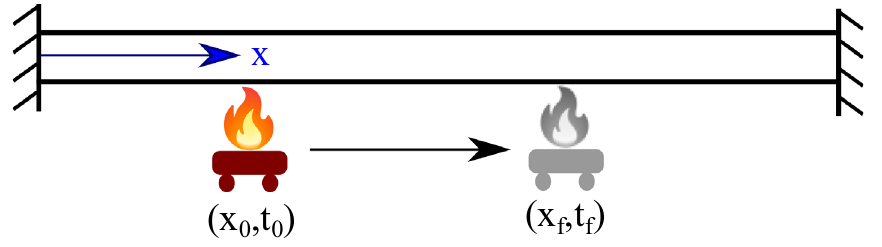
Fig. 1 Schematic representation of the Idelsohn’s benchmark